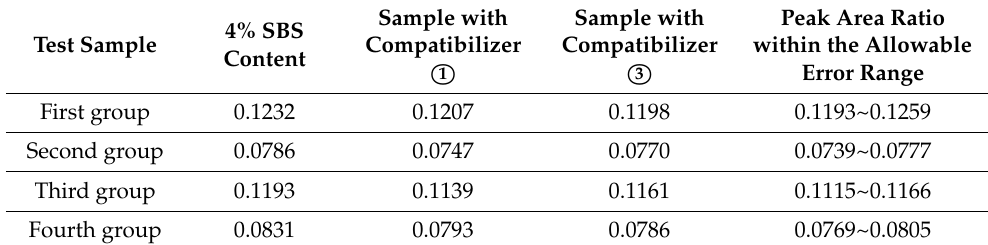
Table 5. Test result of peak area ratio.